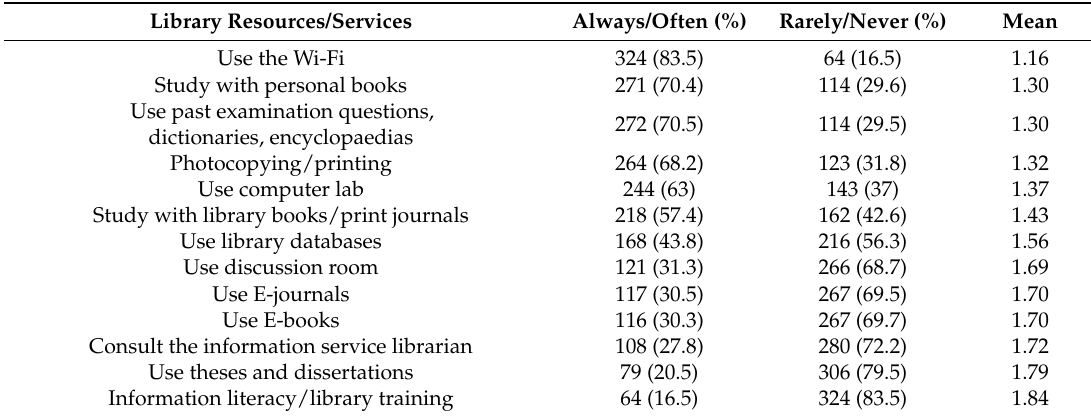
Table 2. Information resources/services used by undergraduate